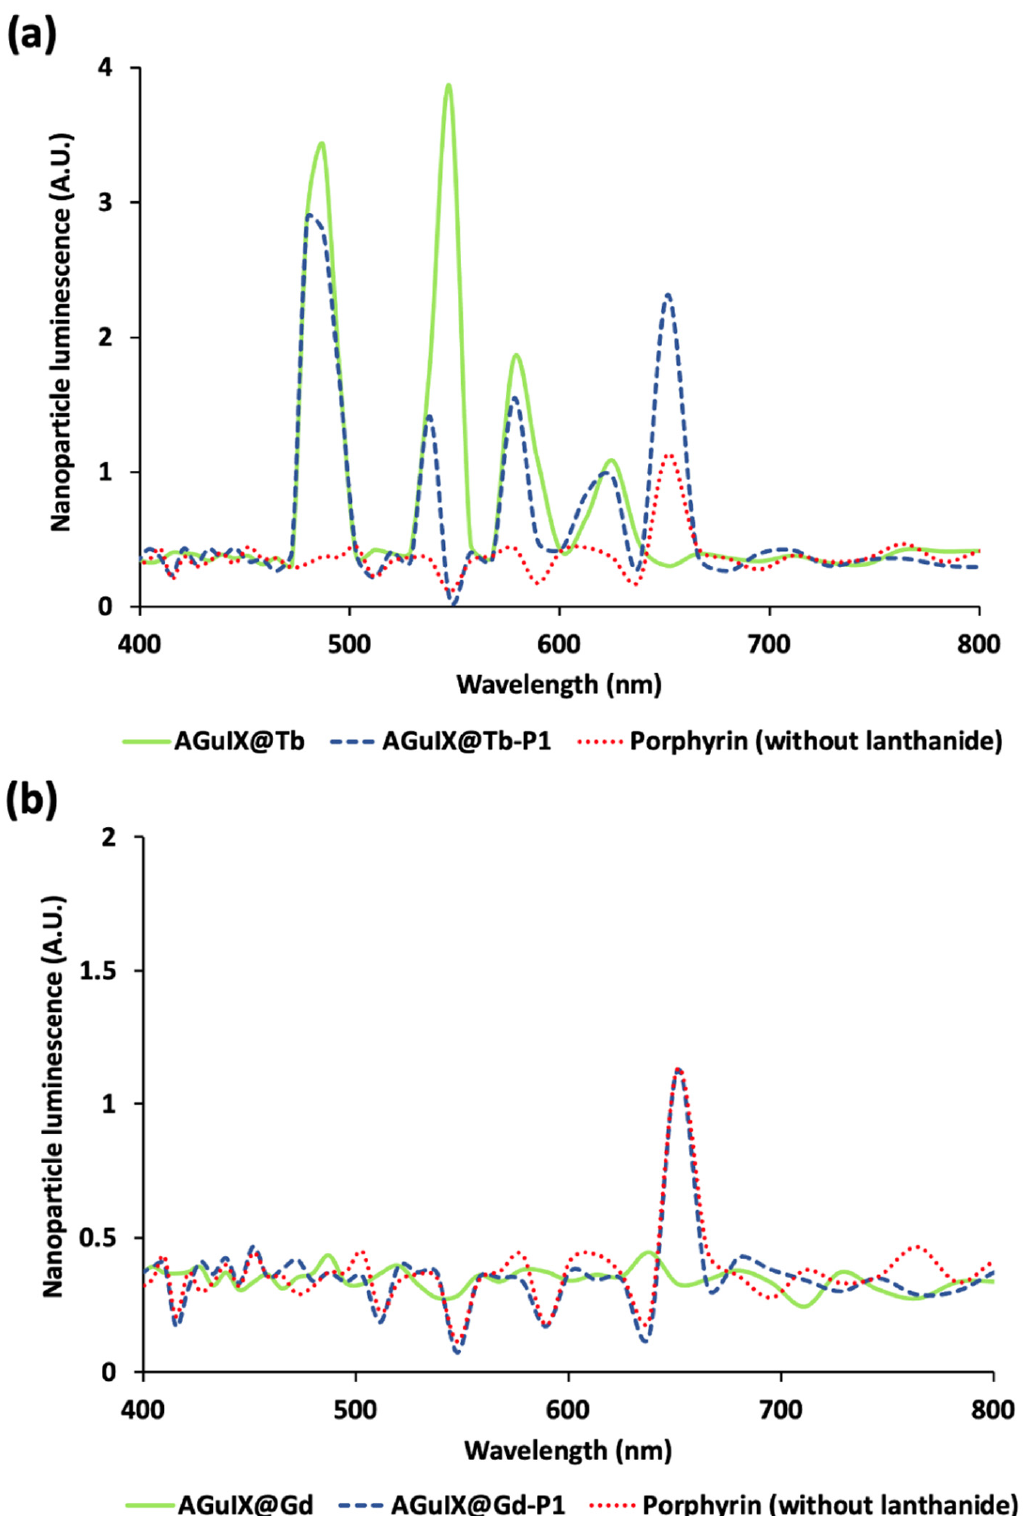
Figure 4. Luminescence spectra of AGuIX nanoplatform with Terbium ( a ) and Gadolinium ( b ) associated with porphyrin. Terbium (Tb) luminescence during Gallium-68 ( 68 Ga) irradiation exhibits the 4 characteristic peaks. In presence of porphyrin (P1), these peaks’ intensities decrease, demonstrating the energy transfer from Tb to P1. Simulations were performed on GEANT4-Gate v. 9.1.